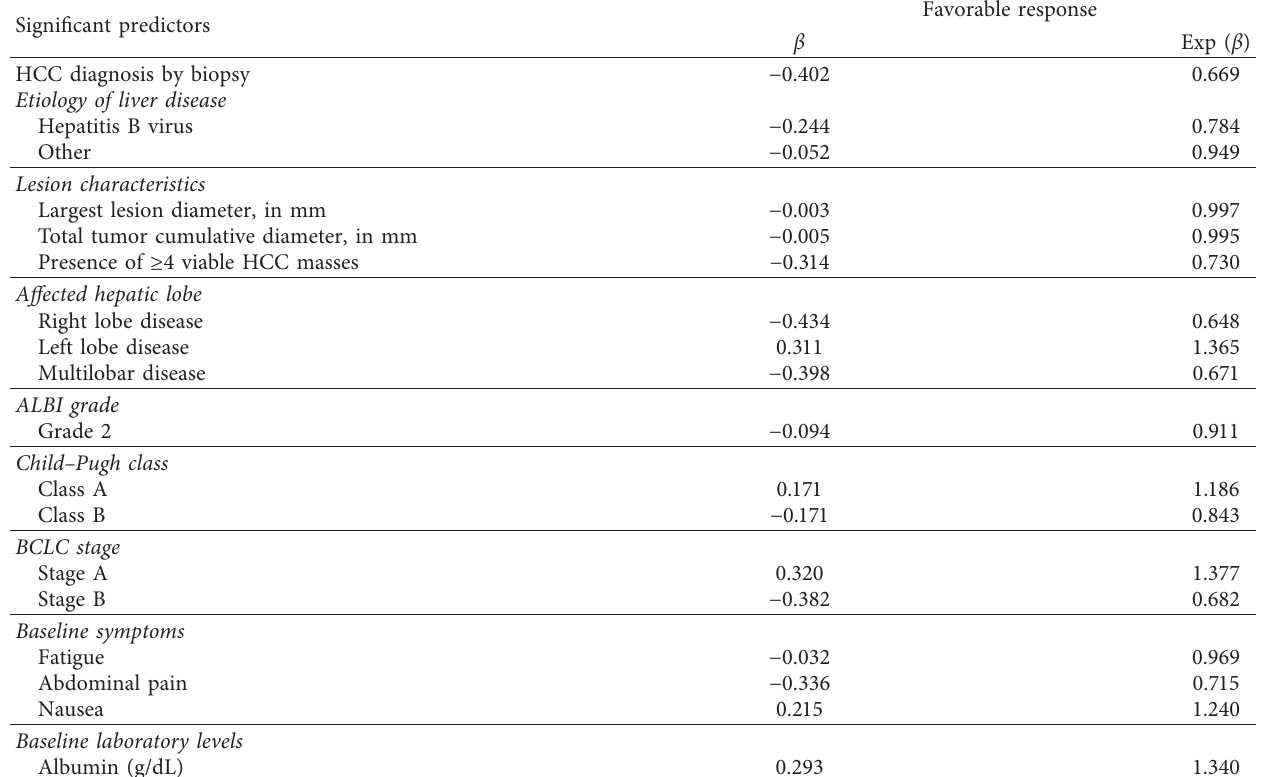
Table 6: Penalized logistic regression analysis of the significant baseline